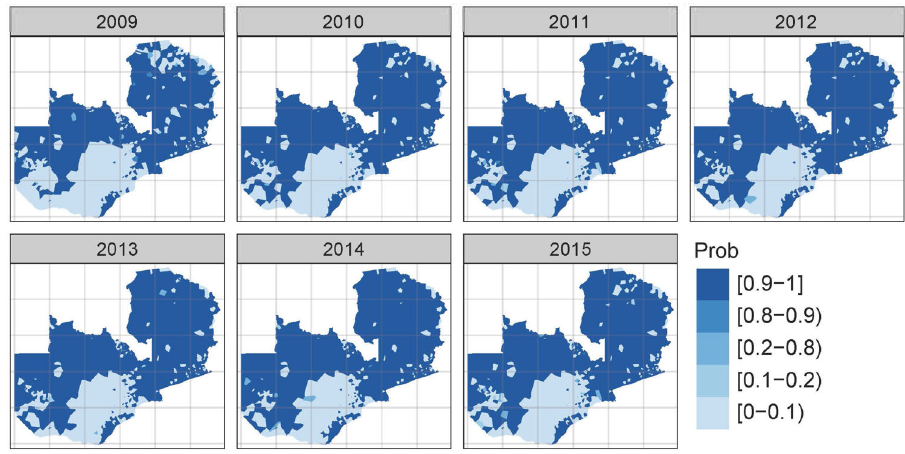
Fig. 6 Posterior exceedance probabilities (greater than a threshold of 50 cases per 1000 population). The posterior exceedance probability threshold is 50 based on strati fi cation used by the country at the time. Light shades indicate a lower posterior exceedance probability or a lower likelihood that the area has a higher incidence than expected, while darker shades indicate a higher than expected